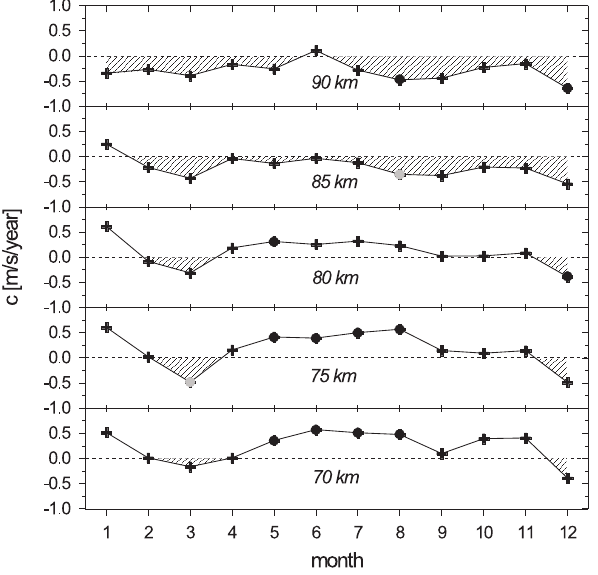
Fig. 16. Seasonal variation of the trend in the mesospheric merid- ional wind at Juliusruh (partial regression coefficient c due to Eq. 1) for different heights. The significance levels χ are marked by black dots ( χ ≥ 95%), grey dots ( χ ≥ 90%), and crosses ( χ< 90%).